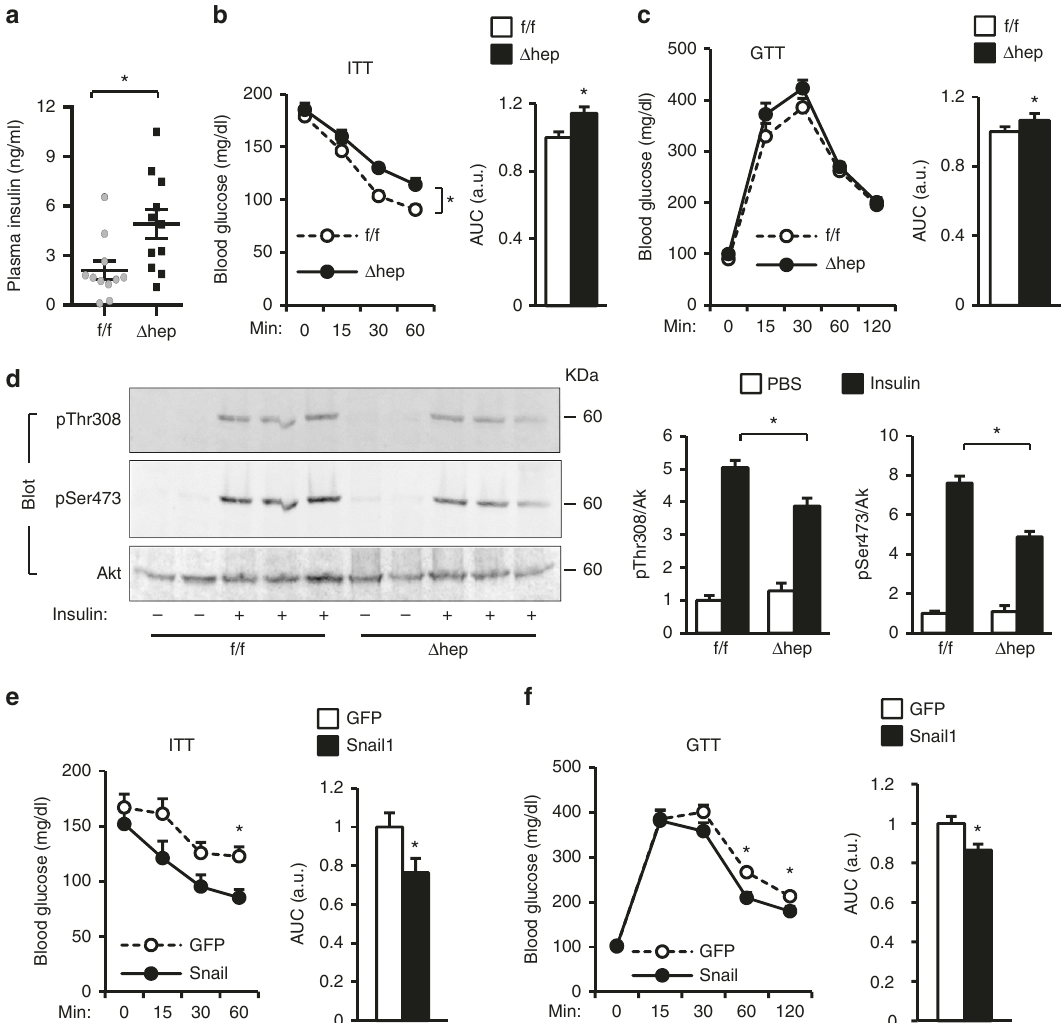
Fig. 7 Hepatic Snail1 ameliorates insulin resistance in obesity. a – d Snail1 Δ hep ( n = 11) and Snail1 fl ox/ fl ox ( n = 11) male mice (8 – 9 weeks) were fed a HFD for 10 weeks. a Overnight fasting plasma insulin levels. b ITT. AUC areas under curves. c GTT. d Mice were fasted overnight (14 h) and injected with insulin (0.5 units/kg). Liver extracts were prepared 5 min later and immunoblotted with anti-phospho-Akt (pSer473 or pThr308) or anti-Akt antibodies. Akt phosphorylation was normalized to total Akt levels. e , f C57BL/6 male mice (8 – 9 weeks) were fed a HFD for 7 weeks and transduced with Snail1 ( n = 10) or GFP ( n = 10) adenoviral vectors for 2 weeks after transduction. e ITT. f GTT. Data are presented as mean ± SEM. * p < 0.05, two-tailed